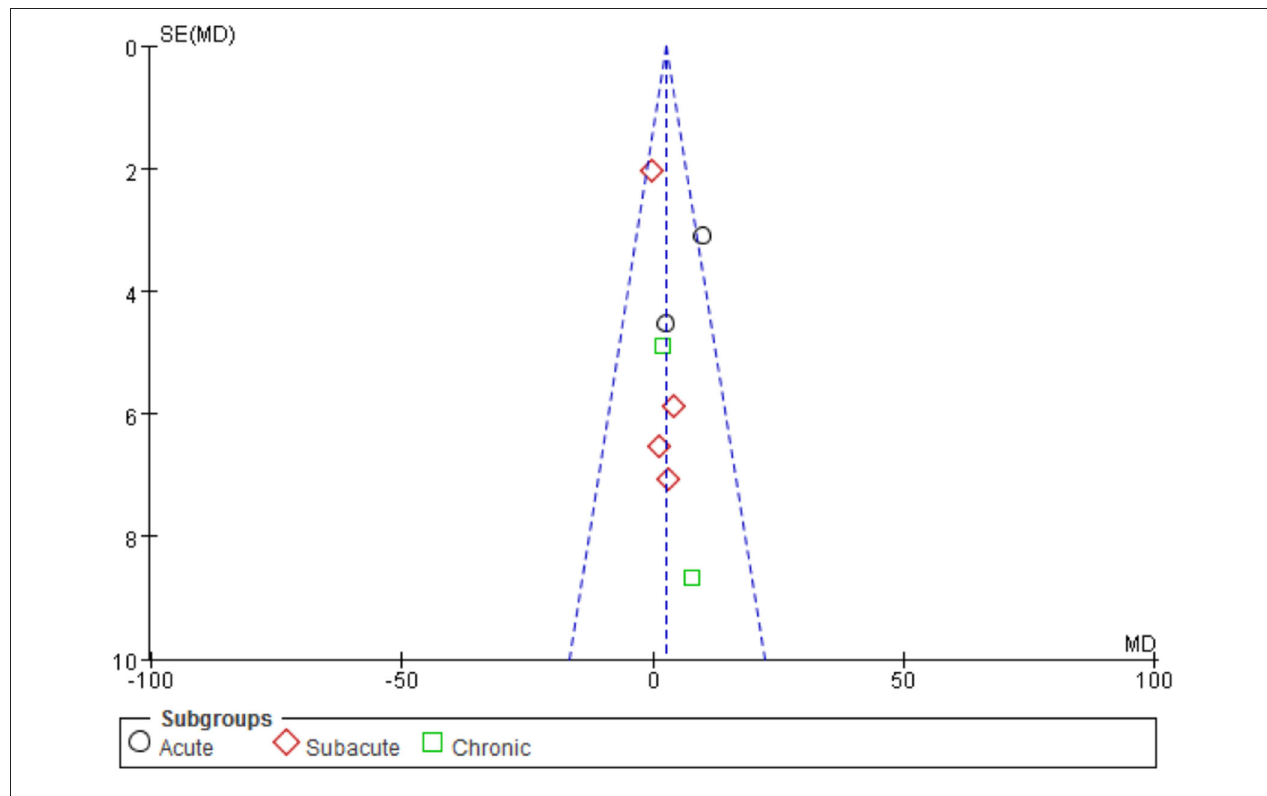
FIGURE 5 | Funnel plots of the pooled results on motor function.